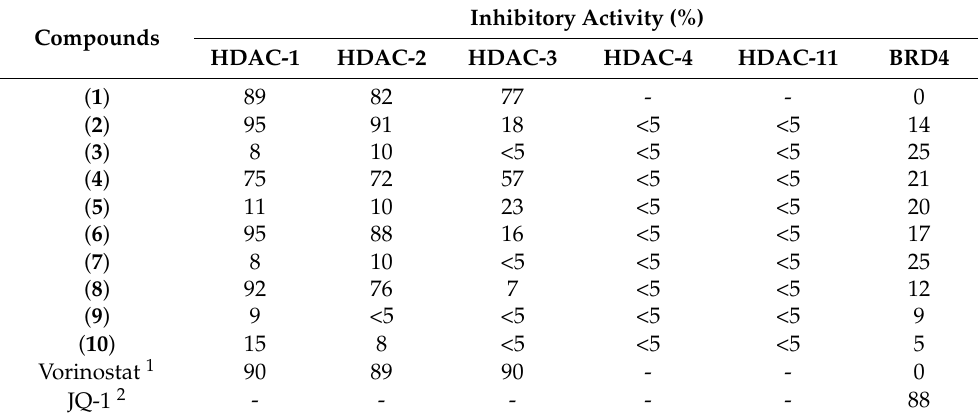
(Figure 1) maintains the molecular recognition of BRD4, probably due to its acetyl-lysine mimetic effect. All compounds ( 2 – 8 ) exhibited effects acting against BRD4 and HDAC class I, mainly HDAC-1 and -2. Table 2. Percentage inhibition effects induced by compounds ( 1 – 10 ) when evaluated against HDAC-1, -2, -3, -4, and -11, and BRD4 at concentration of 10 µ